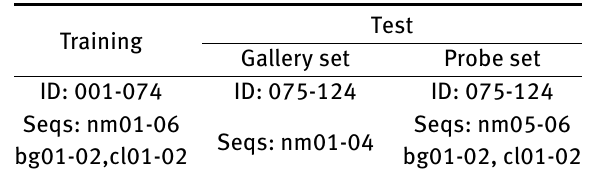
Table 1: Experimental design on CASIA-B dataset.